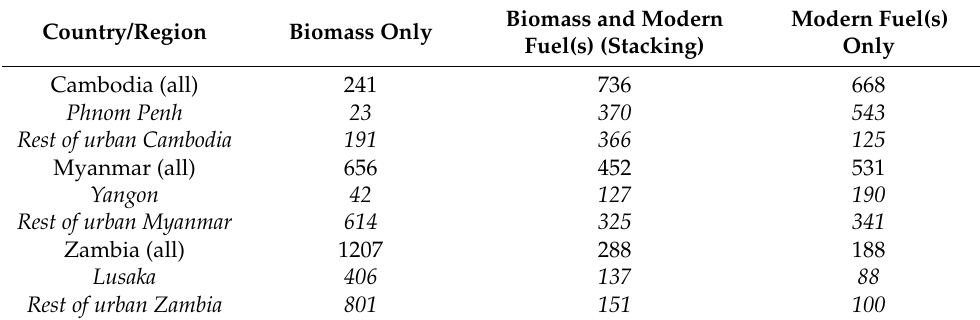
Table 2. Number of surveyed households residing in urban areas, categorised by cooking fuels.